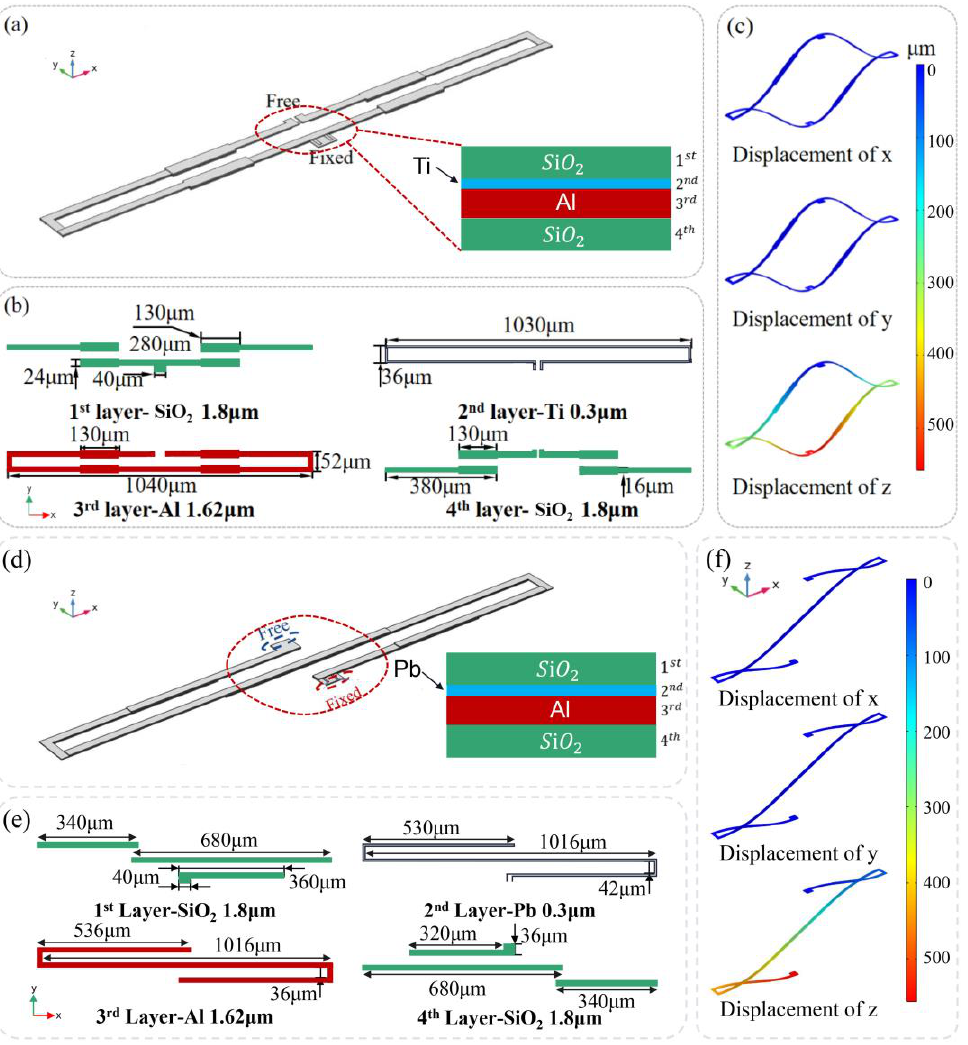
Figure 4. Structure of actuators. ( a – c ) “ O ” type. ( b – f ) “ Z ” type. ( a , d ) Electrothermal actuator. ( b , e ) Each layer of the actuator and the related size information. ( c , f ) The simulation of the actuator.